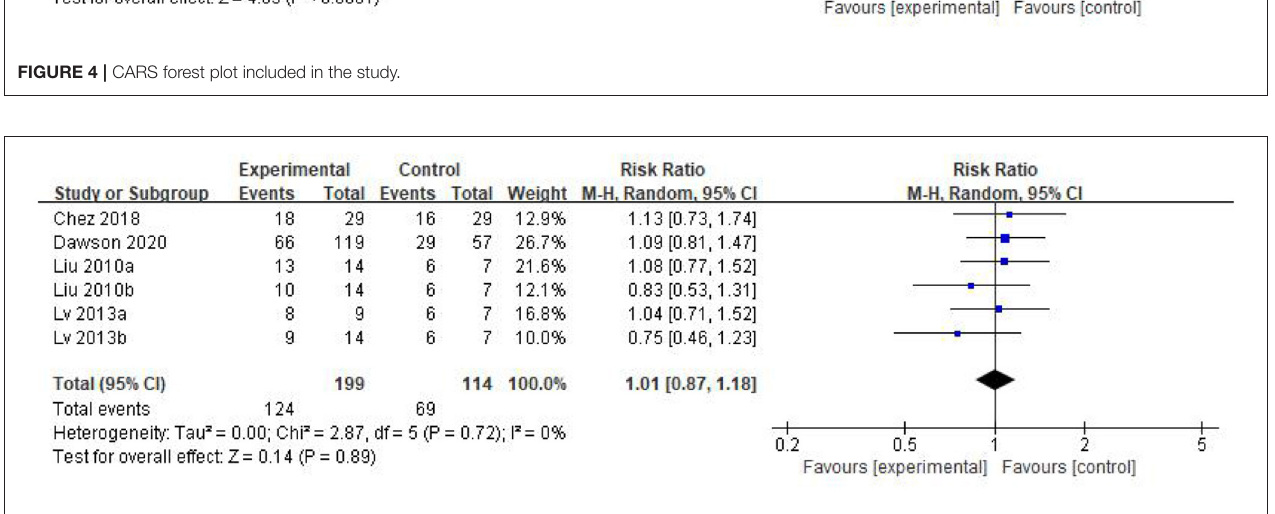
FIGURE 5 | CGI forest plot included in the study.